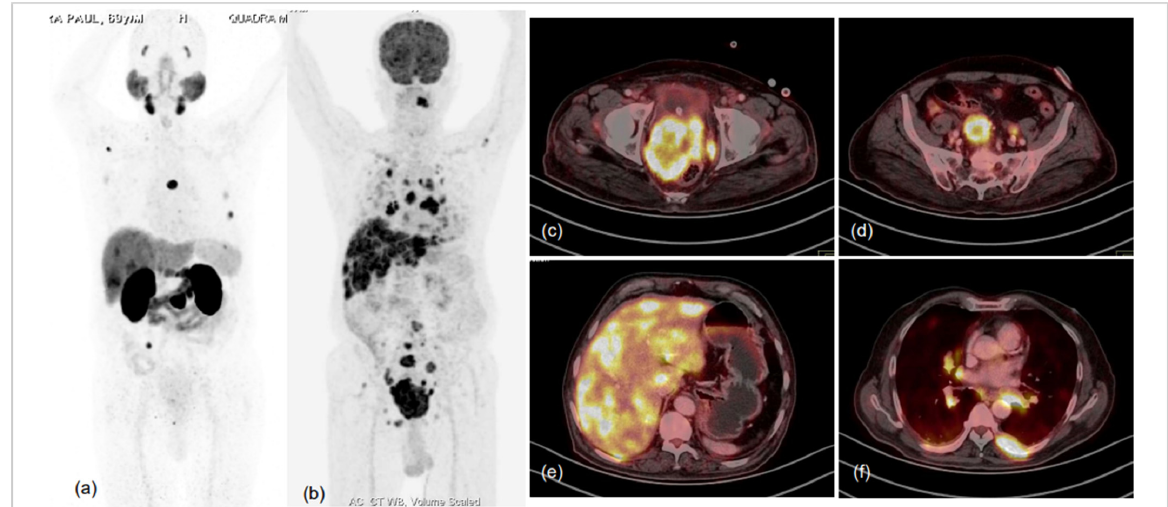
Figure 5. 76-year-old male, attended urologist’s office for lower urinary tract symptoms (LUTS) and prostatomegaly; suspected prostate carcinoma, underwent biochemical evaluation, and serum PSA was 1.120 ng/mL. TRUS-guided prostate biopsy was performed and was diagnosed as high-grade acinar adenocarcinoma (Gleason score 5 + 5 = 10); IHC tumour cells were found to express cytokeratin, EMA, TTF1, synaptophysin, chromogranin A and Mib-1-labelling index of approx. 75%. Hence, a diagnosis of high-grade acinar adenocarcinoma of prostate with small-cell transformation was made and the patient was taken for dual-tracer PET with 68 Ga-PSMA-11 and FDG after deliberate discussion with referring urologist and taking him and the patient into confidence. MIP images of 68 Ga-PSMA-11 ( a ) and FDG ( b ) PET CT scans demonstrated significant discordance in terms of number and intensity of tracer uptake in the lesions, with significantly more lesions showing FDG uptake of increased intensity. Fused trans-axial PET and CT slices of FDG PET-CT ( c – f ) showed FDG-avid lesions with high-grade metabolic activity with visceral (hepatic) and lytic skeletal lesions. The results were in accordance with the known phenomenon of small-cell prostate carcinomas being more aggressive, showing lesser PSMA expression in lesions and being metabolically active due to rapid proliferation.